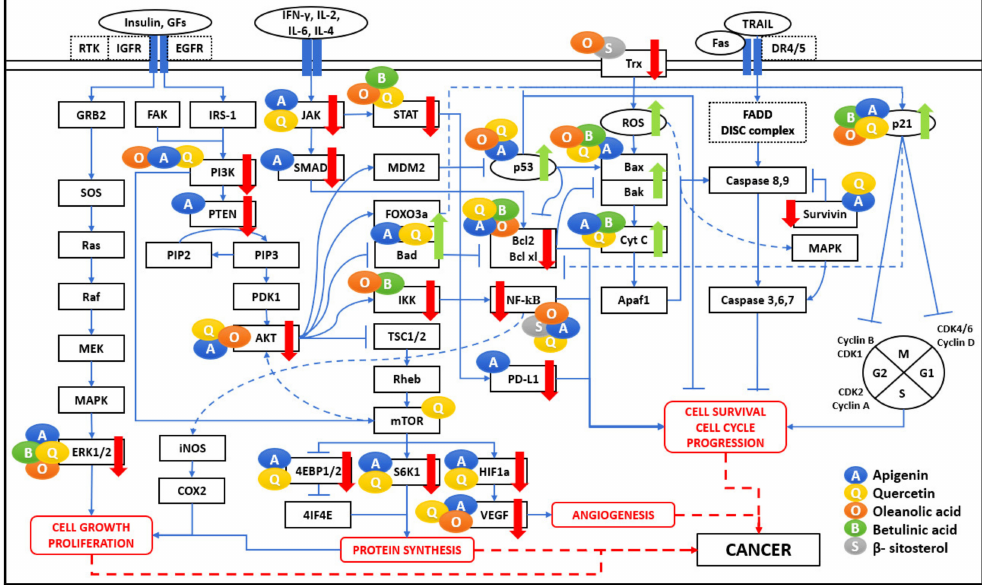
Figure 3. Cancer pathogenesis network. The five bioactive compounds detailed in this review show a range of immunomodulatory activities. Various research articles reported their scattered effects on significant pathways such as NF- κ B, MAPK, PI3K/AKT/mTOR, JAK-STAT pathways regulating cell proliferation, angiogenesis, protein synthesis, cell survival, and cell cycle progression. These bioactive compounds are shown as coloured circles and are indicated alongside their respective molecular targets (Blue: Apigenin, Yellow: Quercetin, Orange: Oleanolic acid, Green: Betulinic acid, Grey: β -Sitosterol). The bold red arrows indicate the downregulation of respective pathways, and bold green arrows indicate the upregulation of the apoptosis pathway. The entities of bold square boxes represent different signaling molecules/complexes. The entities of dotted square boxes represent different receptors for signaling pathways. The entities of circle boxes represent the inducers/activators of the particular pathways. → represents direct activation, —> represents indirect activation, and (cid:97) represents